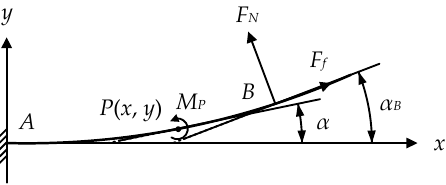
Figure 4. A bending cantilever beam under an inclined load.